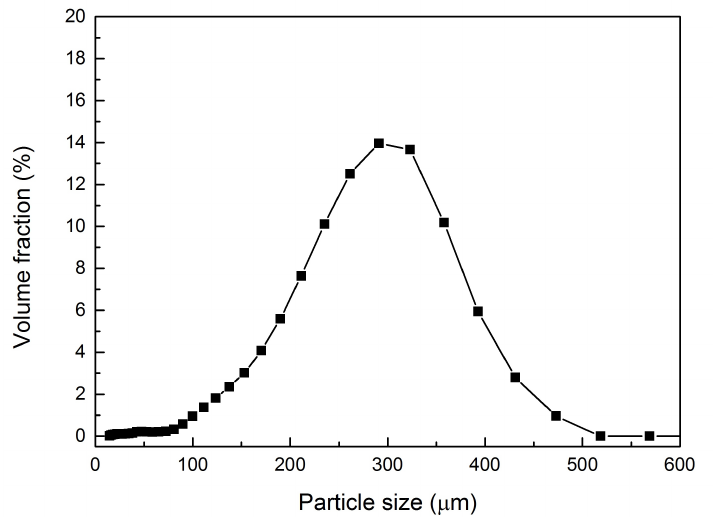
Figure 7. Typical size distribution of microcapsules prepared with a stirring speed at 400